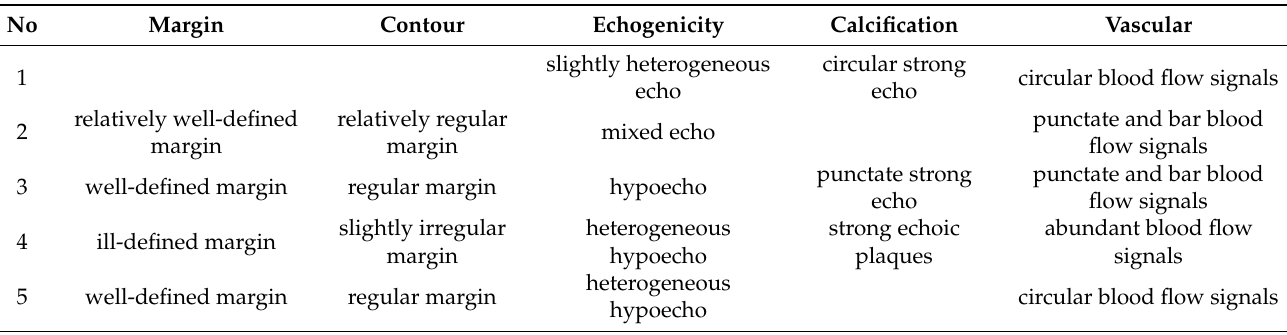
Table 2. Examples of features in the clinical